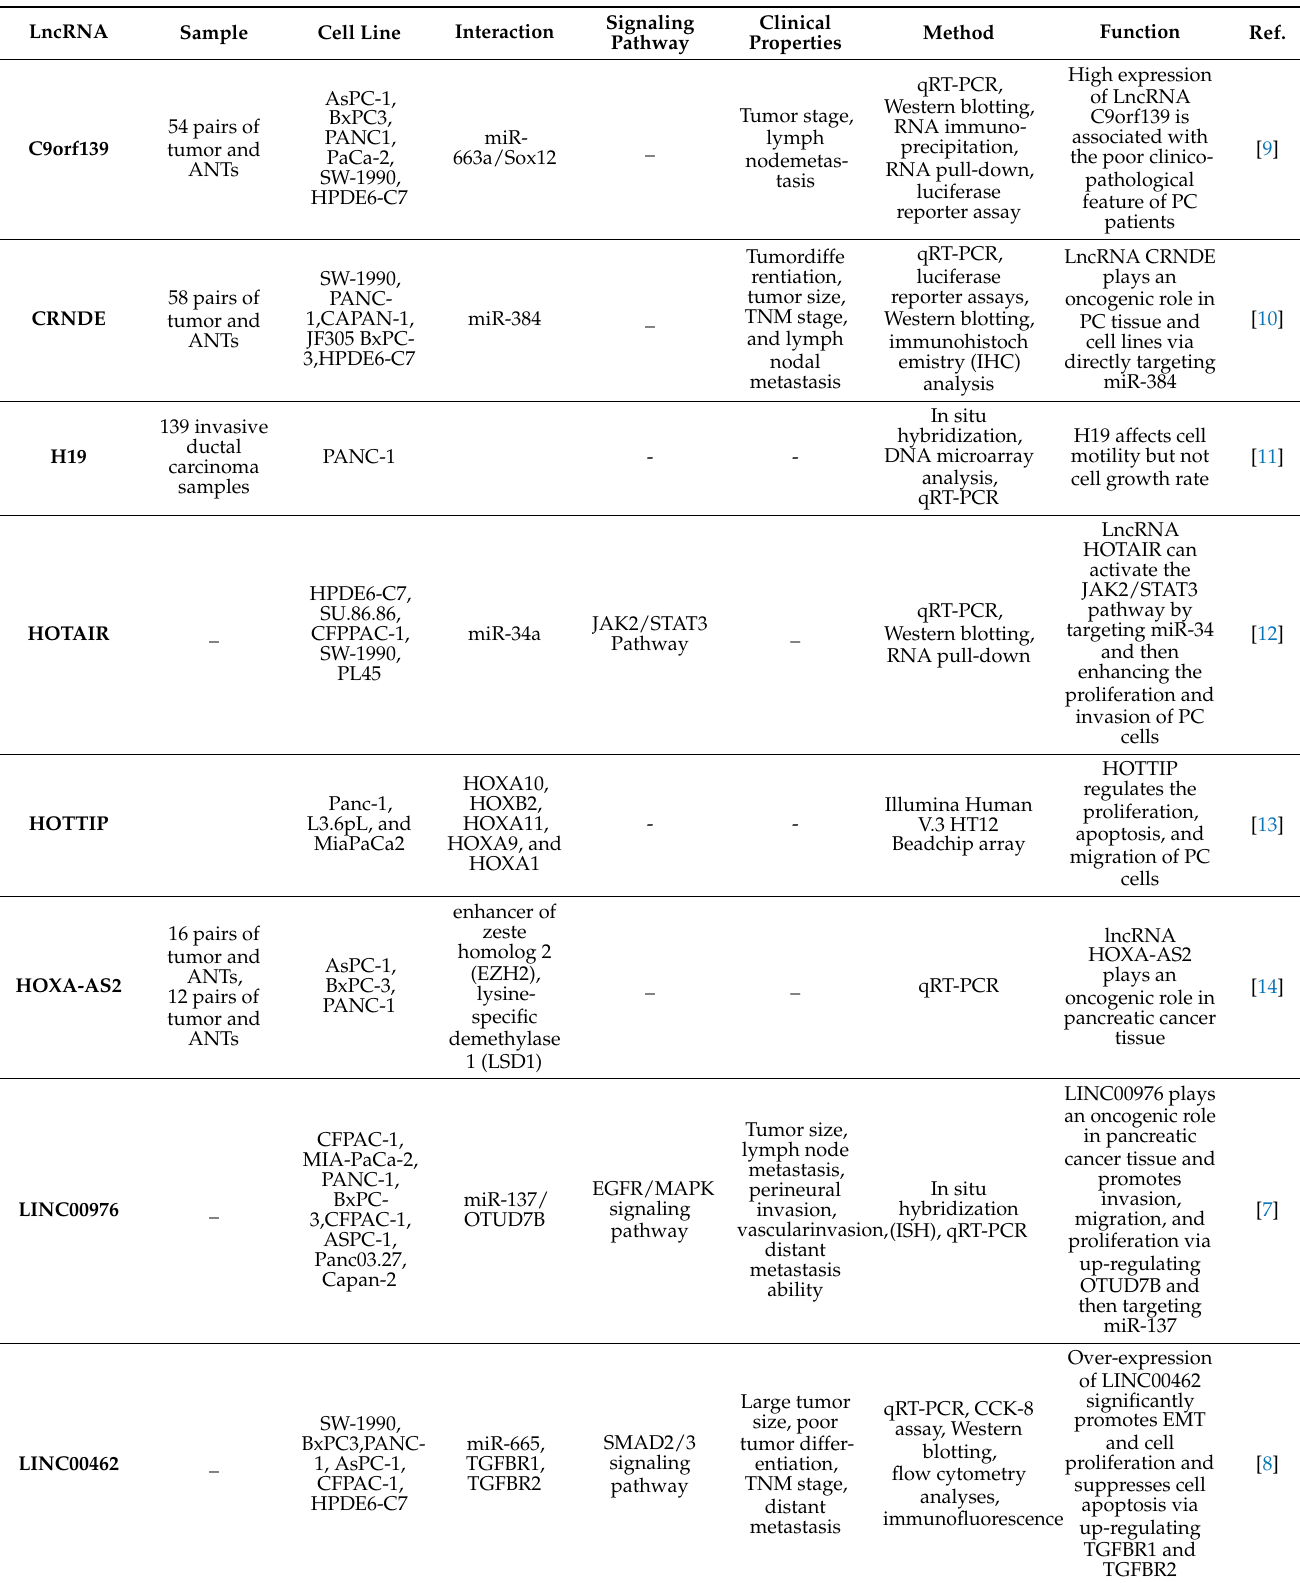
Table 1. List of up-regulated lncRNAs in pancreatic cancer (ANT: adjacent non-cancerous tissue; cell lines were used for functional studies, apoptotic assays, and identification of partners of